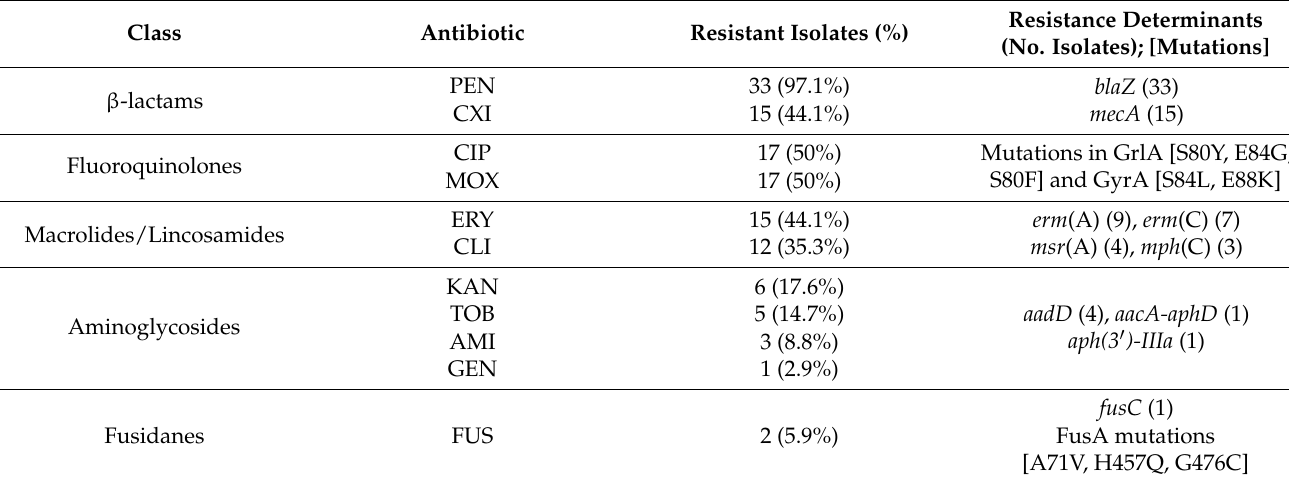
Table 1. Antimicrobial resistance phenotypes of the 34 S. aureus included in this study and correlation with resis- tance